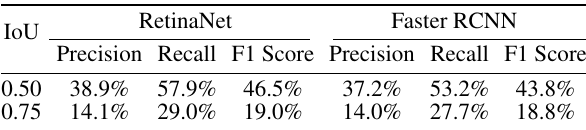
Table 2. Quantitative results obtained with the two deep neural networks and two IoU